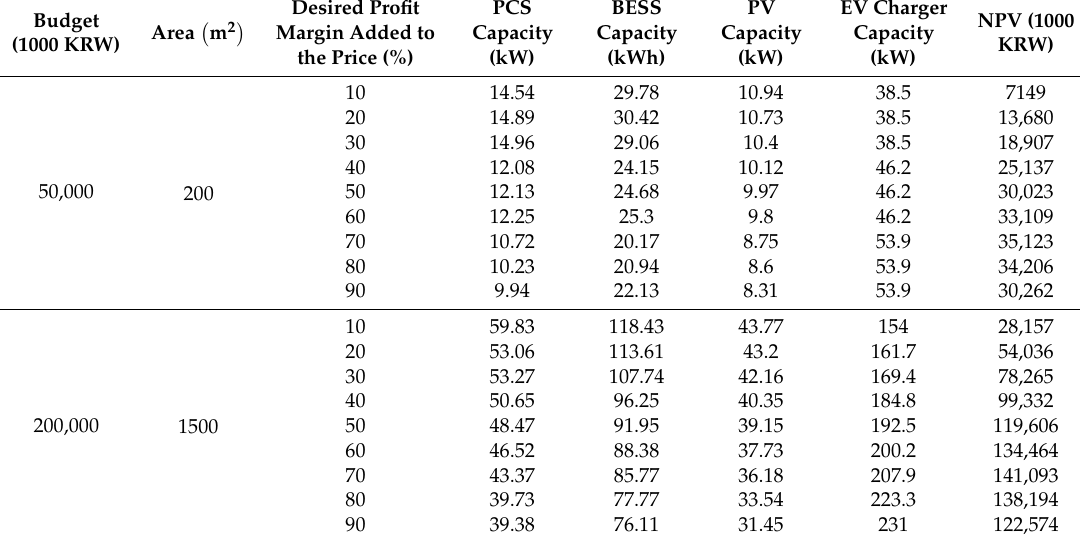
Table 9. Simulation results for Case C with base prices of